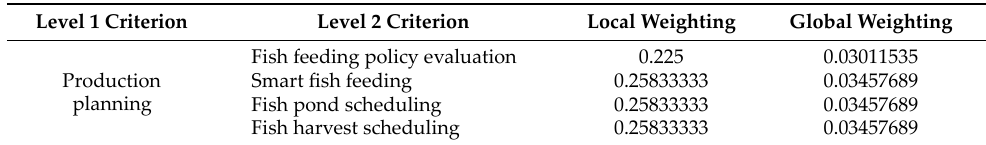
Table 11. Level 2 priority evaluation results for the Level 1 ‘production planning’ criterion using the modified AHP.